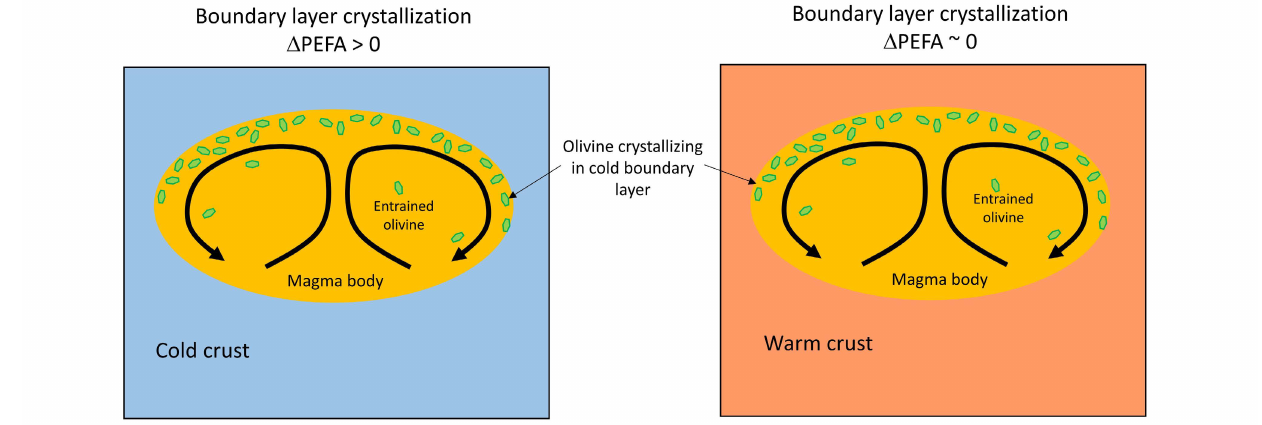
Figure 9: Scenario 2 where olivines crystallize in the cold boundary layers of large, long-lived magma chambers and then get re-entrained into the magma body. Temperature contrast between magma body and crust control cooling rate in the boundary layer. Deep-seated magma bodies in arc systems may display lower temperature contrast with the crustal wall rock, resulting in slower cooling. In contrast, shallow magma bodies, such as in mid-ocean ridge environments, might be surrounded by cold crust, resulting in rapid